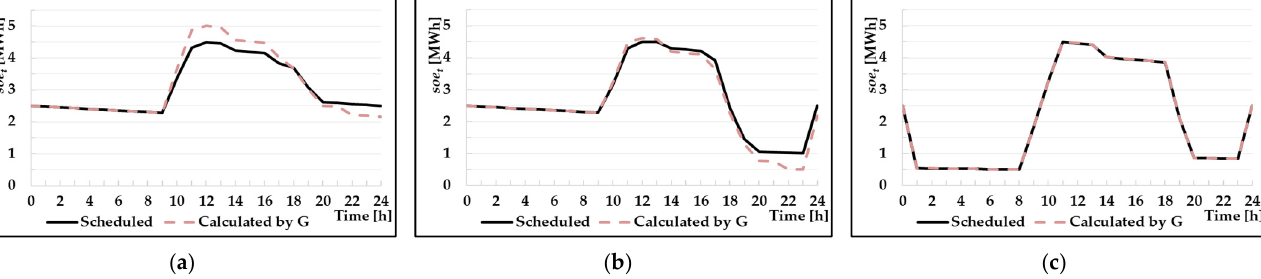
Figure 10. Variations in soe t for Scenario C using methods ( a ) I 70 , ( b ) I 80 , and ( c ) II.